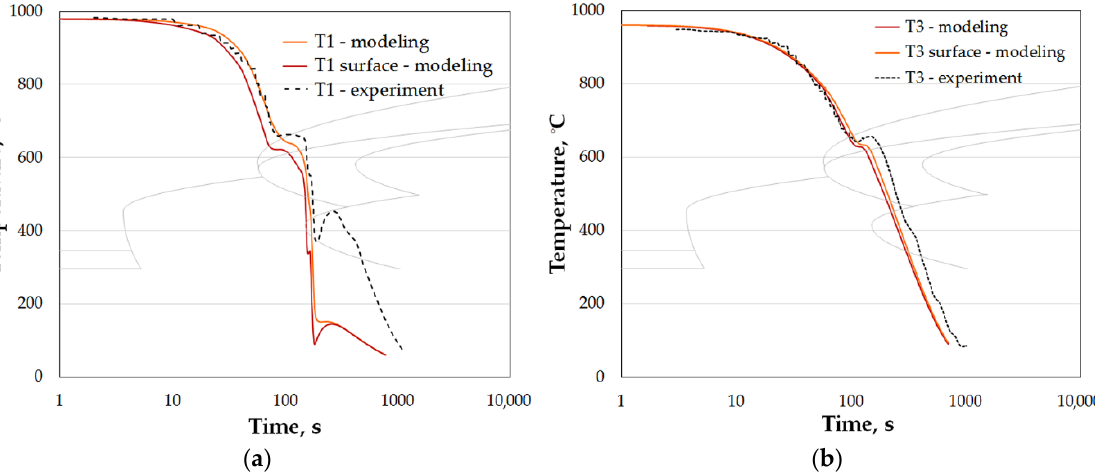
Figure 15. Numerically calculated temperature plots (color lines): ( a ) location T1 (cooling with spray + accelerated air 18 m/s), and ( b ) location T3 (cooling with fan accelerated air 18 m/s); dotted line indicting experimental plot for cooling with the same quenchant alone for previous settings, shown in Table 2.